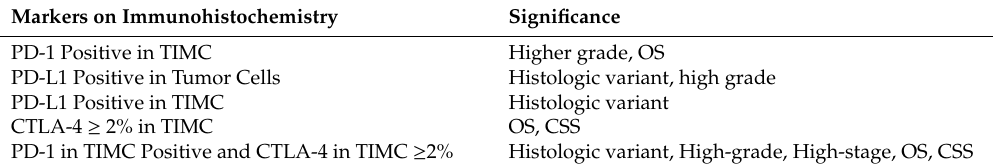
Table 3. Protein expression of immunological markers and their clinical significance in clinical